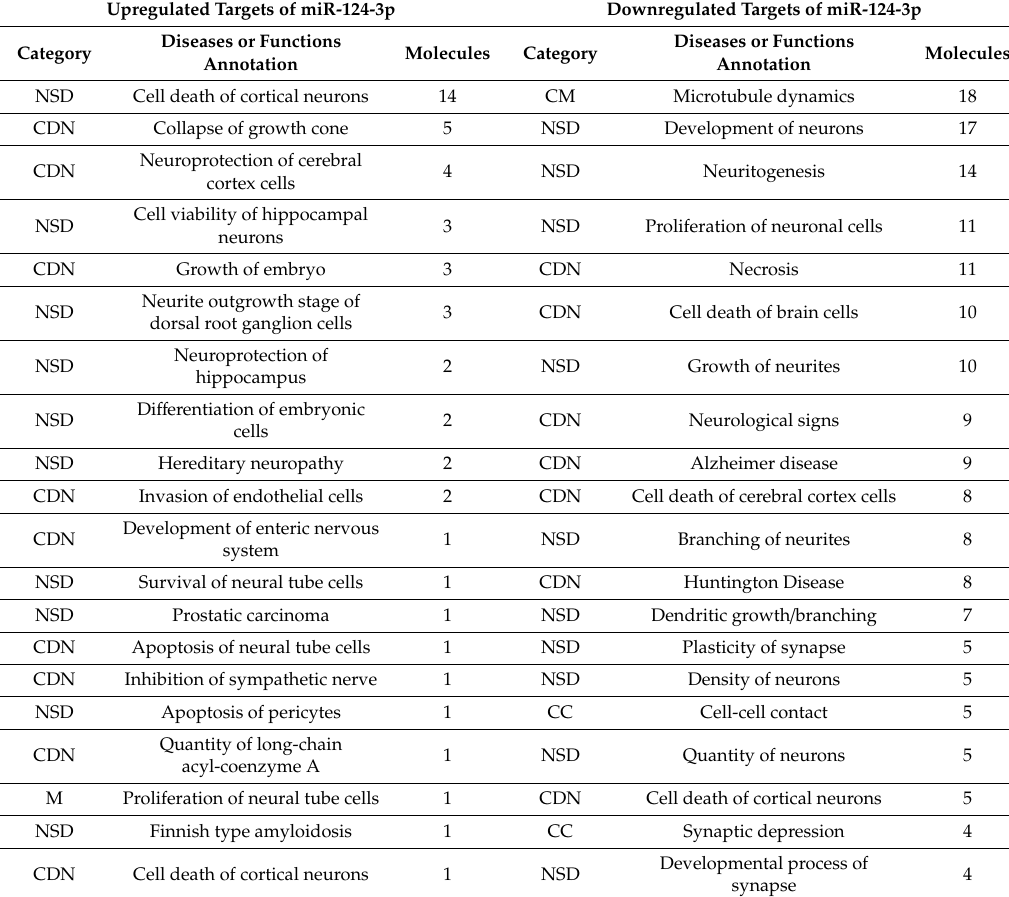
Table 3. Ingenuity pathway analysis of miR-124-3p targets with di ff erential expression in the perilesional cortex at 3 months post-TBI. Twenty pathways with the most mapped targets are